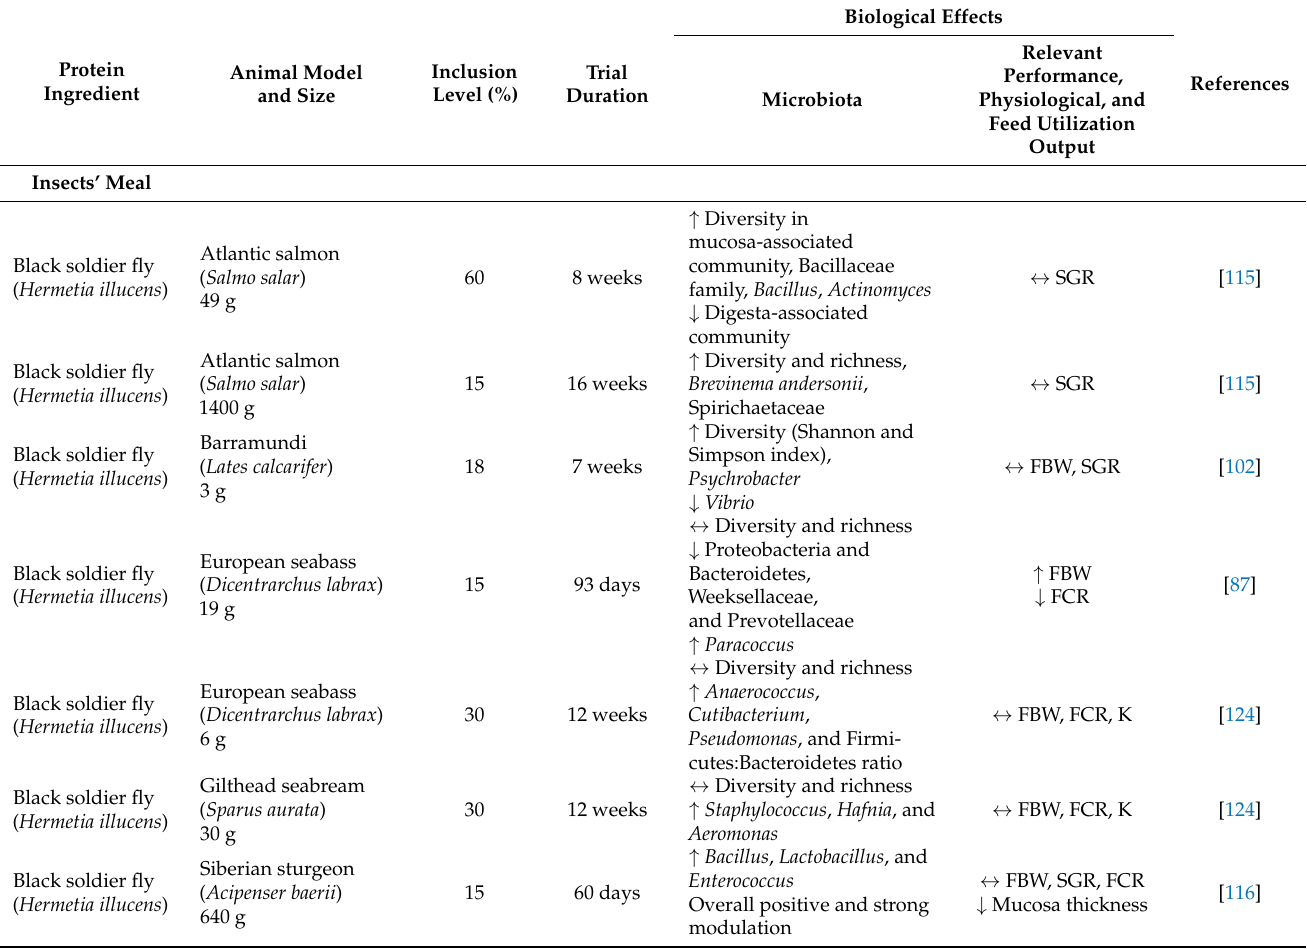
Table 2. Summary of insects’ meal and their impacts on fish intestinal microbiota